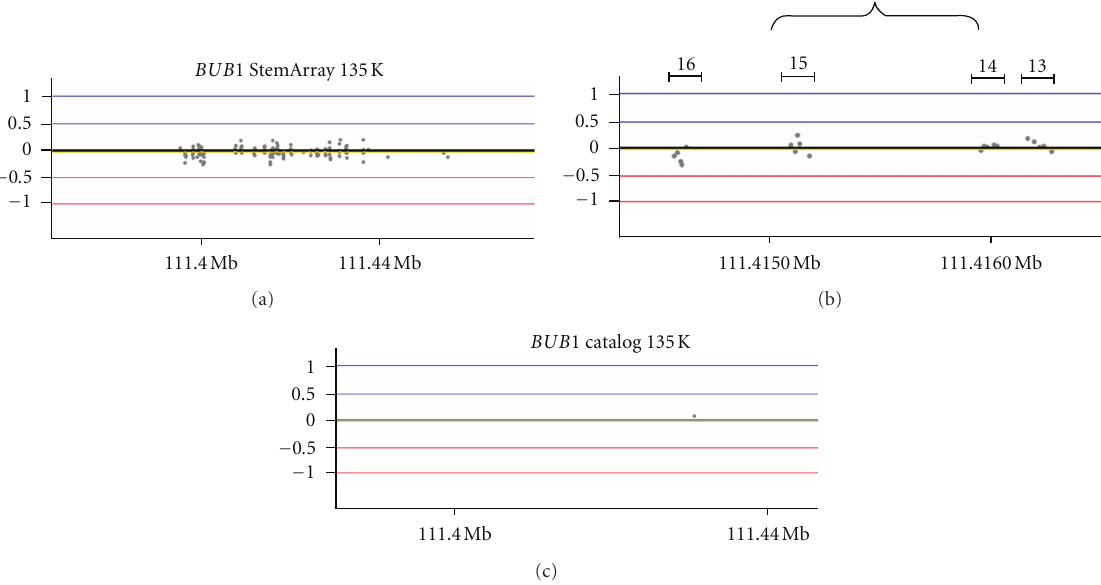
Figure 1: The 135K StemArray has increased probe coverage in stem cell and cancer-associated genes. (a) Stemness gene BUB1 contains 141 total probes resulting in single exon resolution. (b) Exons are covered with 5 probes/exon enabling the detection of a single exon deletion or amplification. (c) In comparison, the standard NimbleGen catalog 135 K array only contains a single probe in the BUB1 gene and therefore does not have the resolution to detect a variation in this